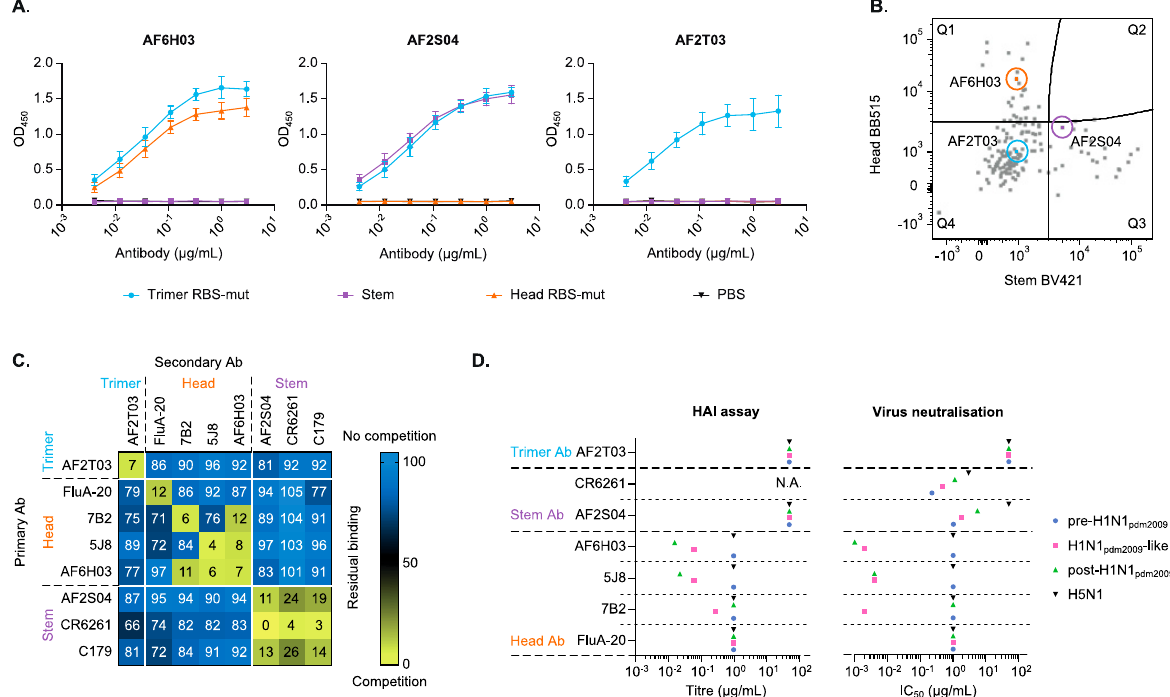
Figure 3. Binding domain and functional analysis of HA-trimer, head and stem specific mAbs. ( A ) The antibody binding patterns of the three mAbs in Strep-Tactin XT ELISA coated with the HA-trimer (blue), monomeric head (orange) and trimeric stem (purple). ( B ) Index sorting showing the flow cytometry plot highlighting the B cells that yielded the three mAbs studied further. The plot shows merged staining profiles of sorted trimer specific B cells of two HDs. ( C ) A heatmap of a competition assay with well characterized mAbs and the newly discovered mAbs. The values represent the residual binding of secondary antibody in combination with the primary antibody after pre-incubation of the HA-trimer protein, ranging from no competition (blue) to (strong) competition (yellow). ( D ) The antibodies were tested in HAI (left panel) and virus neutralization (right panel) assays against the autologous H1N1 virus, two heterologous H1N1 viruses and an H5N1 virus. The antibodies are grouped according to their binding domain. When no neutralization or HAI was observed the IC50 or titer were set at 50 µg/mL for trimer and stem specific antibodies and 1 µg/mL for head specific antibodies. CR6261 was not tested in HAI (N.A.).